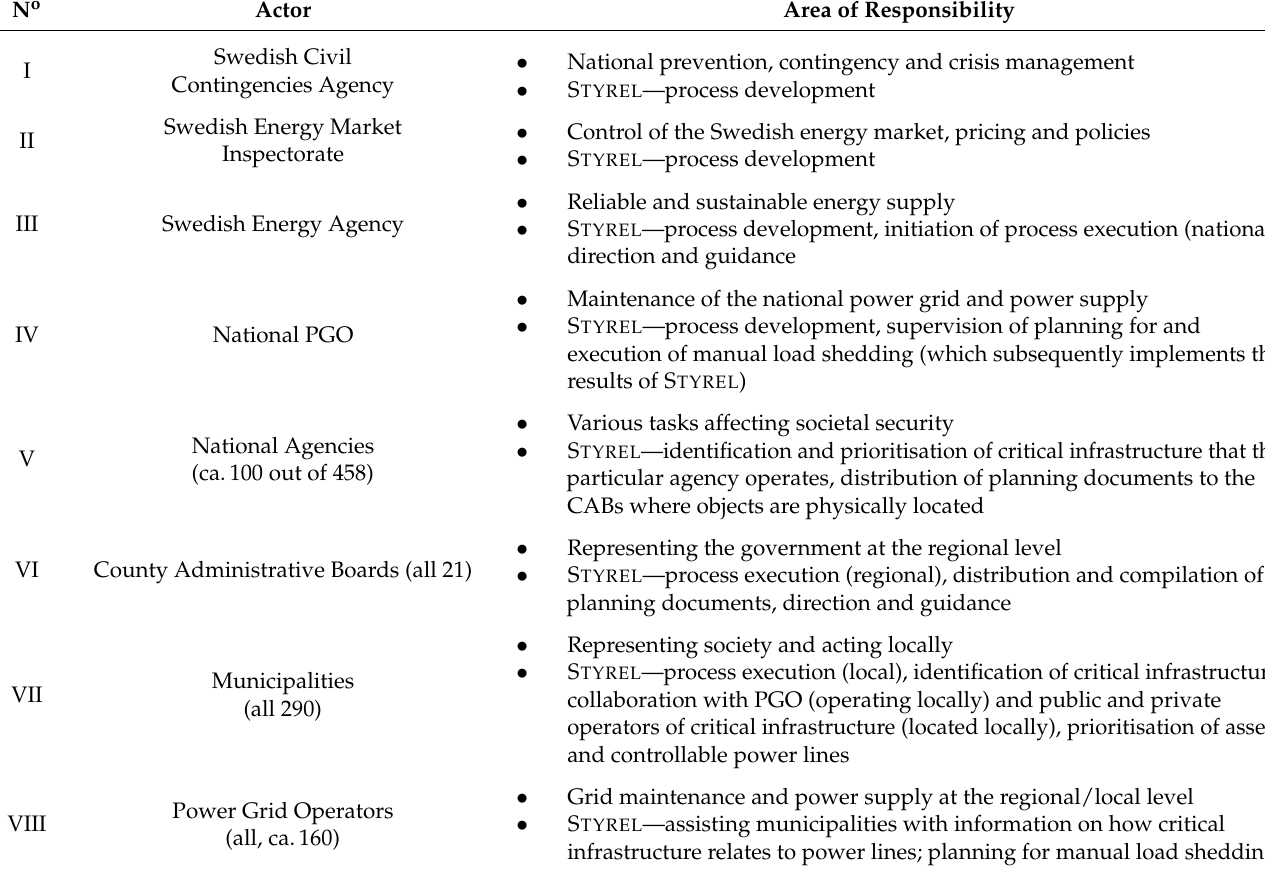
Table 1. Actors in the Swedish planning approach—S TYREL .